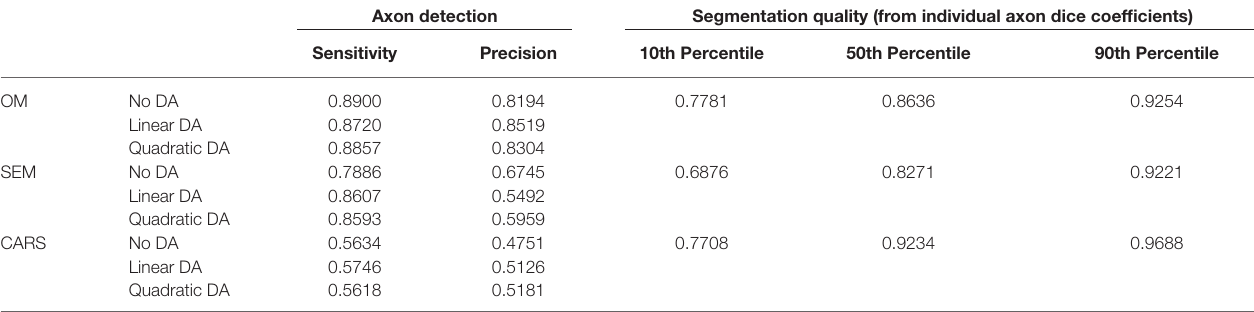
TABLE 1 | Assessment of axon detection and segmentation quality provided by